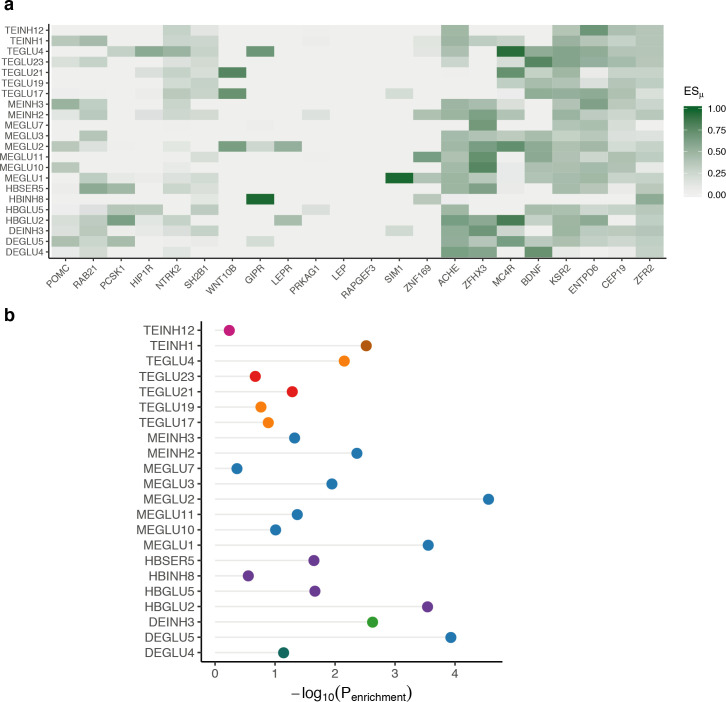
High-confidence obesity genes enrichment in mouse nervous system cell types.(a) Heatmap showing ESμ values for high-confidence obesity genes (columns) for BMI GWAS-enriched cell types (rows). (b) Cell type enrichment of high-confidence obesity genes for BMI GWAS-enriched cell types. The high-confidence obesity genes and mouse nervous system enrichment results are available in Figure 5—source datas 4 and 6.